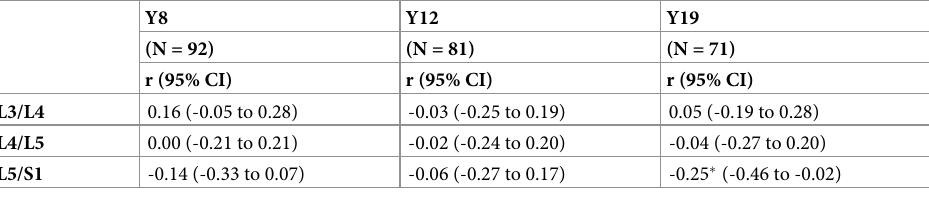
Table 3. The Spearman correlation between BMI and Disc to CSF -SI